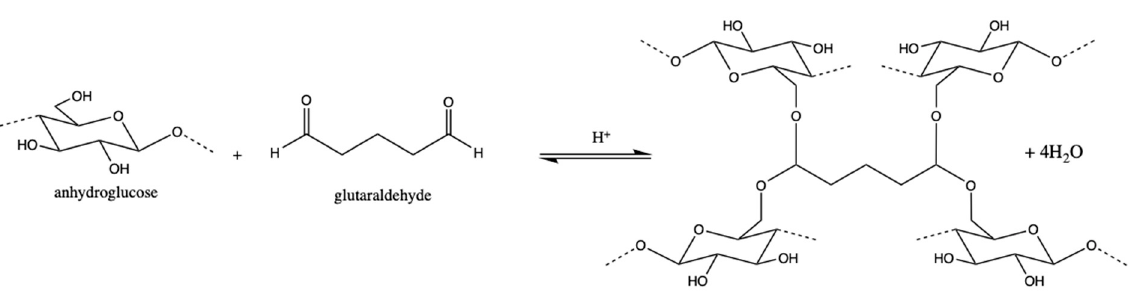
Figure 1. Schematic illustration of the preparation steps (from 1 to 5) for networked–nanofibrous cellulose (NC).